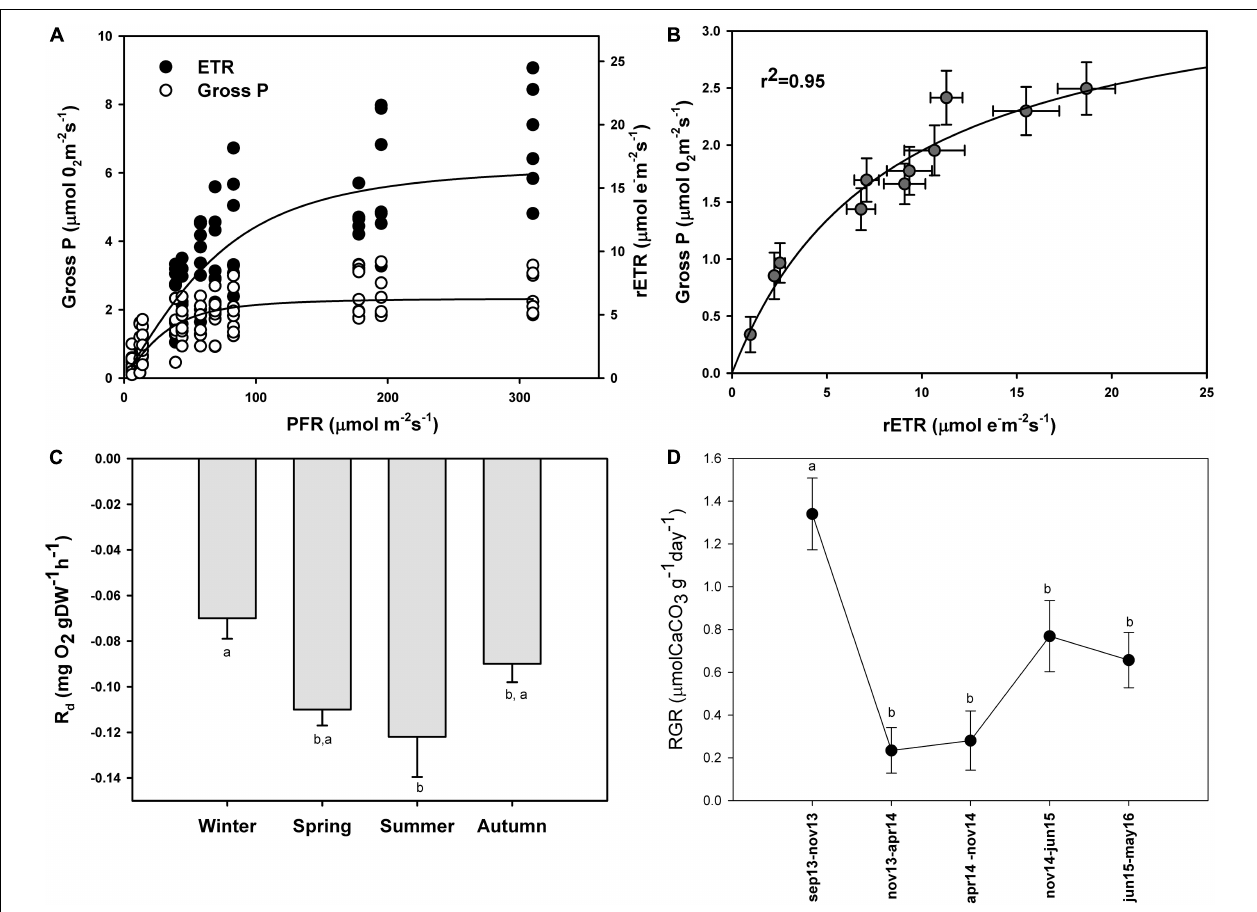
FIGURE 5 | Simultaneous measurements of oxygen evolution (Gross P.; µ mol O 2 m − 2 s − 1 ) and relative electron transport rates (rETR; µ mol e − m − 2 s − 1 ) in P. lusitanicum (A) . Gross photosynthesis vs. rETR relationship (B) ( n = 8). Seasonal variation of dark respiration rates of P. lusitanicum (R d , mg O 2 gDW − 1 h − 1 ) measured in the laboratory ( n = 10). (C) Relative growth rate of P. lusitanicum (RGR) from September 2013 (Sep 13) to May 2016 (May 16) determined on marked individuals on the field ( n = 160) (D) . Mean values ± standard error. Different letters indicate significant